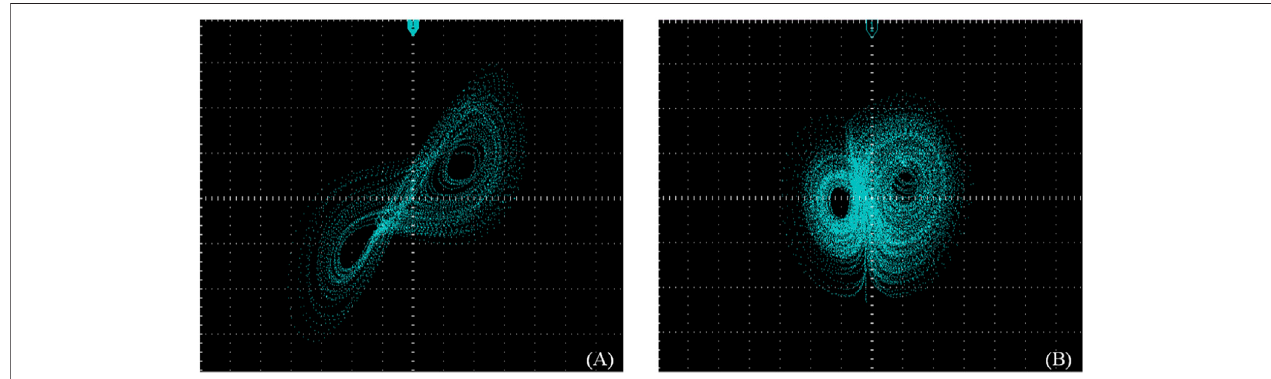
FIGURE 12 | Chaotic attractor on the DSP platform: (A) X - Y plane, (B) X - W